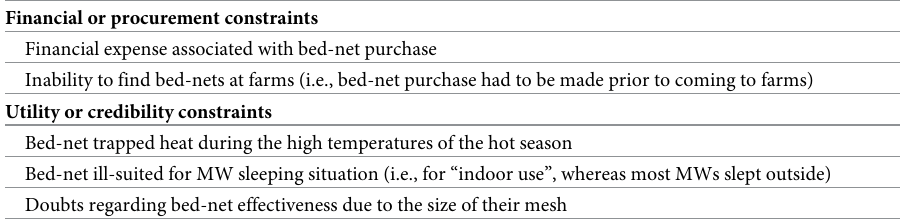
Table 4. Reasons for non-use of bed